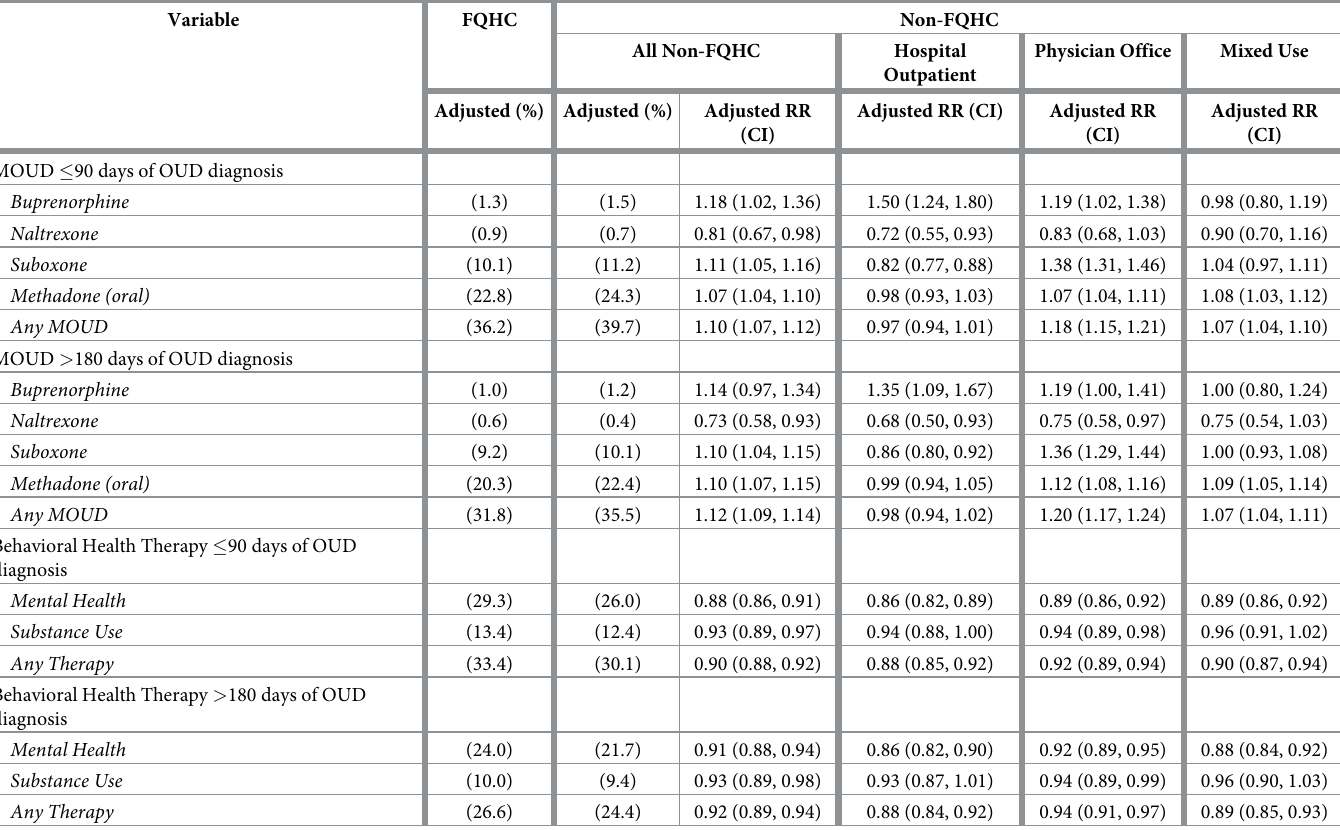
Table 3. Use of MOUD and behavioral health therapy among patients with at least six months of continuous Medicaid enrollment after OUD diagnosis by primary care setting: United States, 2012. Variable FQHC Non-FQHC All